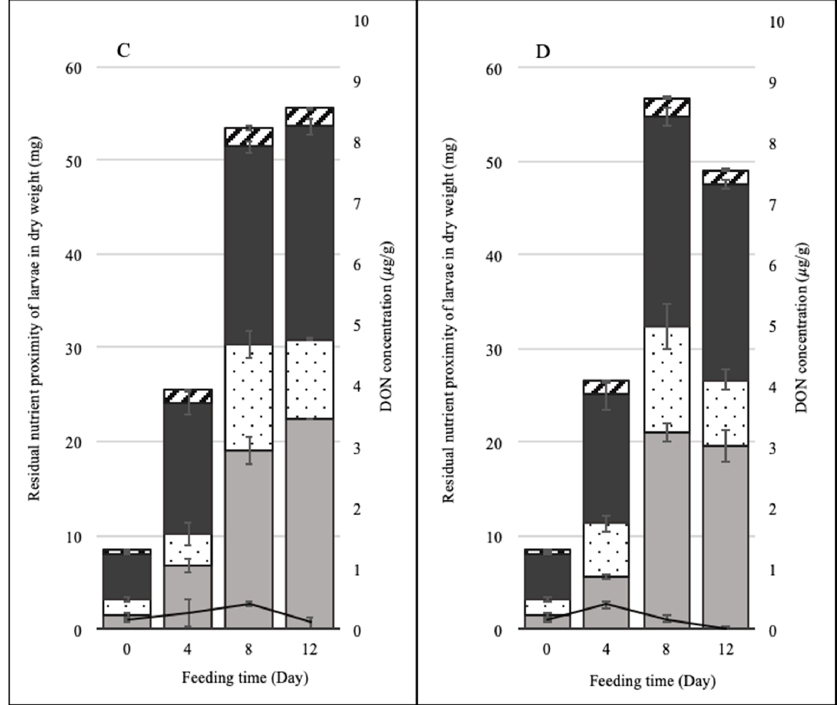
Figure 2. Weight gain, proximate composition, and deoxynivalenol (DON) concentration of larvae during black soldier fly larvae rearing. The overall length of each bar shows the dry weight of larvae divided according to the ratio of nutrients: hatched area, ashes; gray area, lipids; dotted area, carbohydrates; black area, proteins; the lines, DON concentration in black soldier fly larvae. Each panel represents the results of larvae from ( A ) Fusarium-damaged kernels (FDK) without inoculum (i.e., unfermented FDK), ( B ) FDK with Lactobacillus plantarum , ( C ) fermented FDK with Aspergillus oryzae , and ( D ), fermented FDK with both L. plantarum and A. oryzae